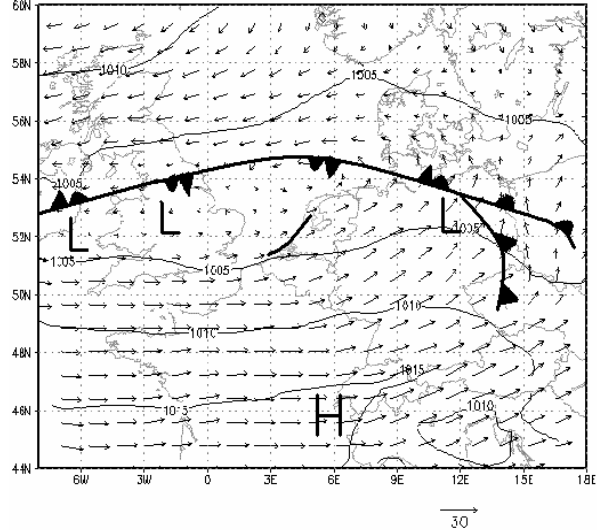
F2 Fig. 2. The sea level pressure (hPa) and wind vectors at 640hPa with drawn fronts, during the coastal front situation on 13 August 2004 at 03:00 UTC.